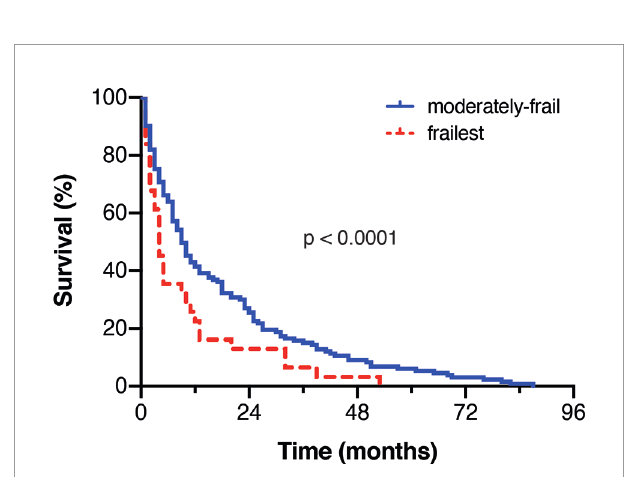
FIGURE 2 | Kaplan Meier-survival curves strati fi ed by the extent of frailty.